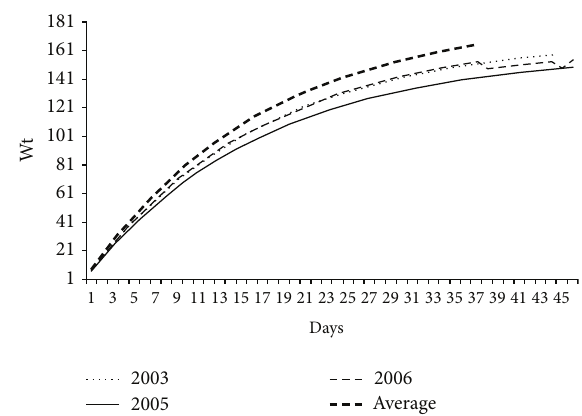
Figure 17: Model of adjustment of the growth curve of Sterna hirundinacea chicks at Ilha dos Cardos during the breading seasons of 2003, 2005, and